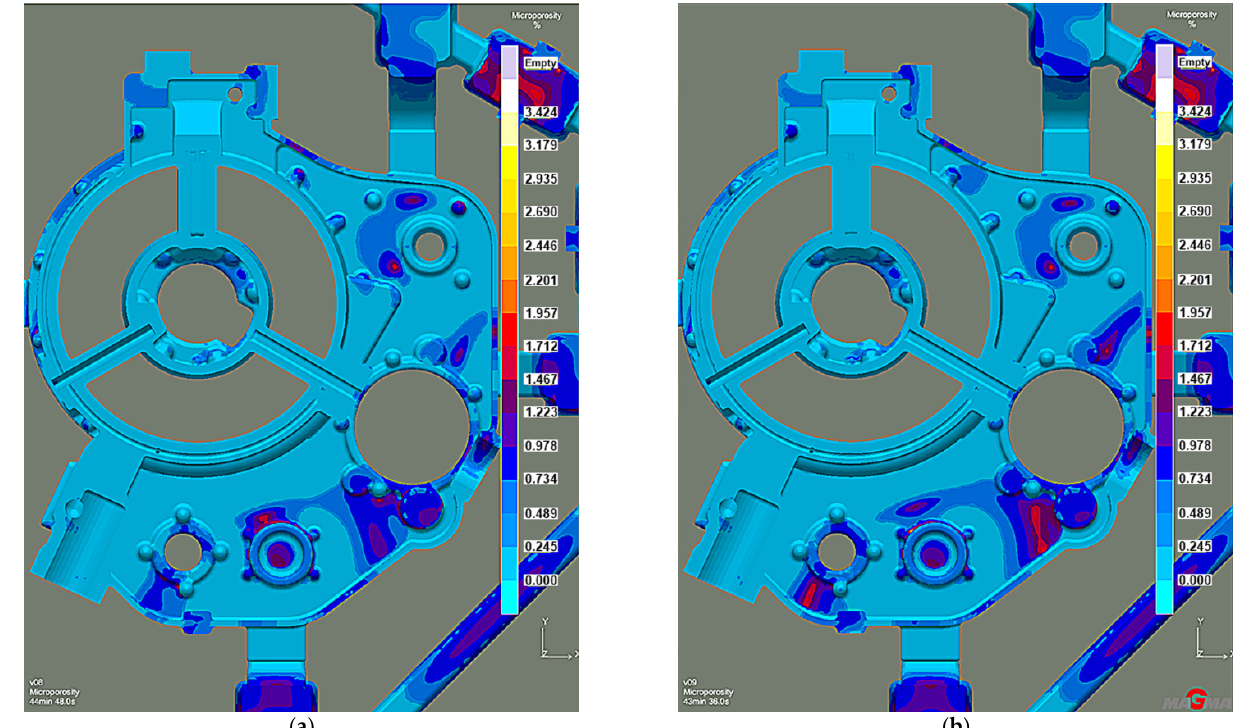
Figure 20. Stage 5 Microporosity criterion: ( a ) 10 mm chiller thickness; ( b ) 15 mm chiller thickness.